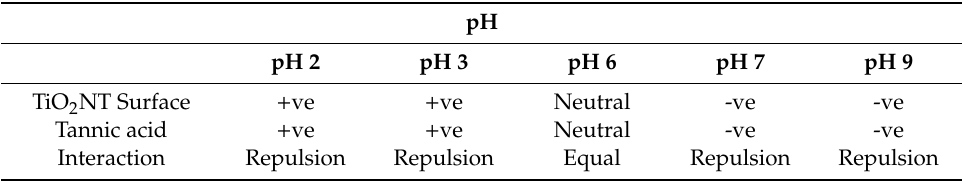
Table 4. Summary of the charges and interactions under di ff erent pH conditions between the TiO 2 NT surface and tannic